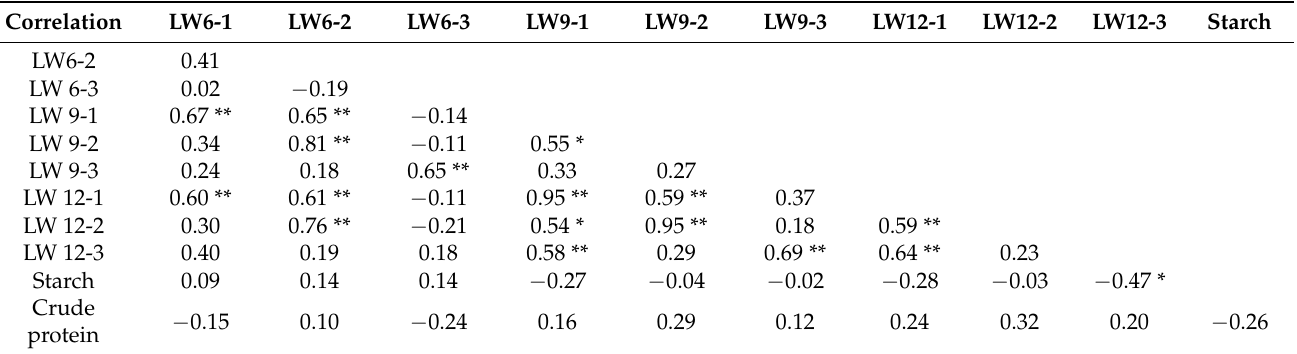
Table 4. Correlation analysis of insect weight index and physiological index of sensitive and resistant yardlong bean varieties in three verification experiments.